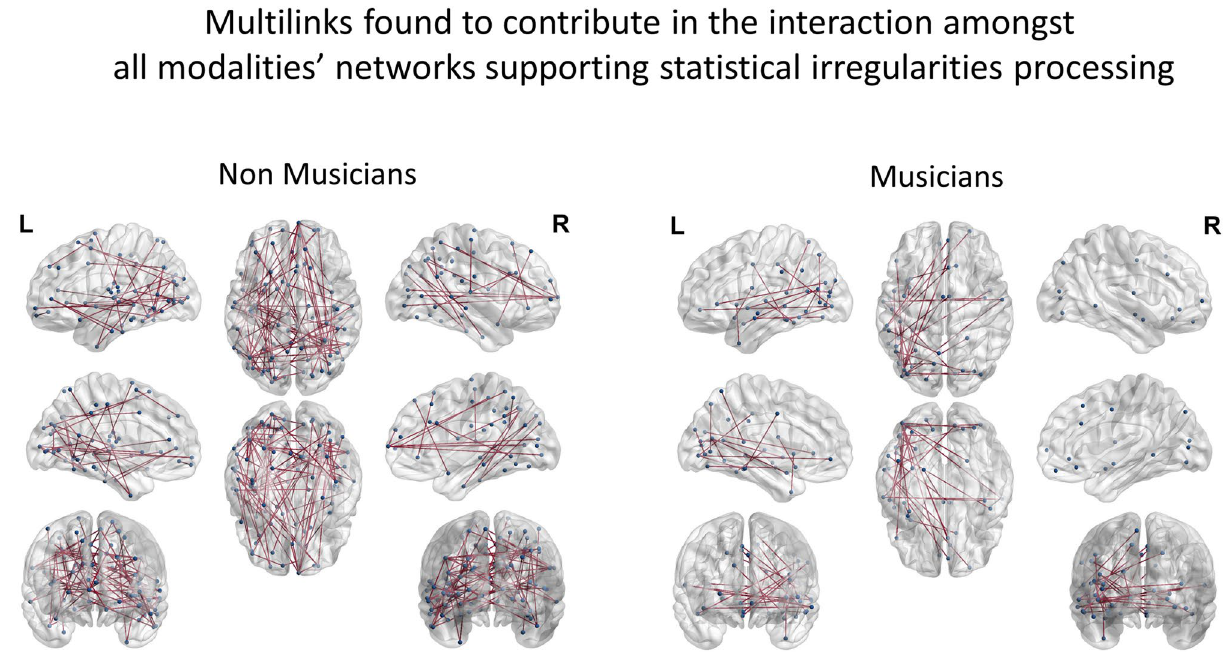
Figure 3. Supramodal mechanism of statistical learning: Regions underlying the interaction amongst all modality-specific networks subserving the identification of stimuli violating transitional probabilities for non- musicians and musicians.